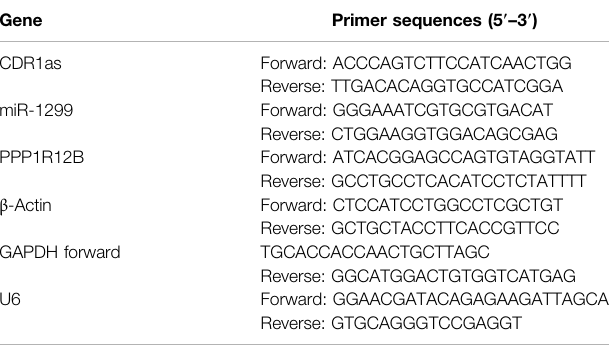
TABLE 1 | Primer sequences for real-time PCR.